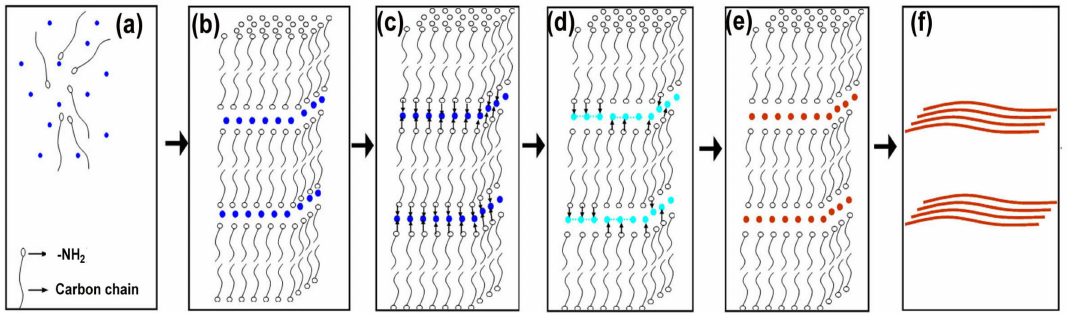
Figure 5. Schematic illustration of the growth of ultra-long Cu nanowire bundles: ( a ) oleylamine molecules disperse randomly in the water; ( b ) oleylamine molecules self-assembly into lamellar micelles; ( c ) Cu(oleylamine) 2 (OH)Cl complexes form within the micelles; ( d ) complex polymers, namely Cu 3 (oleylamine) 3 OH and Cu 3 (oleylamine) 2 (OH)Cl, form as Cu(II) is reduced to Cu(I); ( e ) Cu(I) species are further reduced to Cu; ( f ) nanowire bundles form. Arrows in Figure 7c,d represent the complexation. Cu(II), Cu(I), and Cu are indicated by blue, sky blue and red dots,